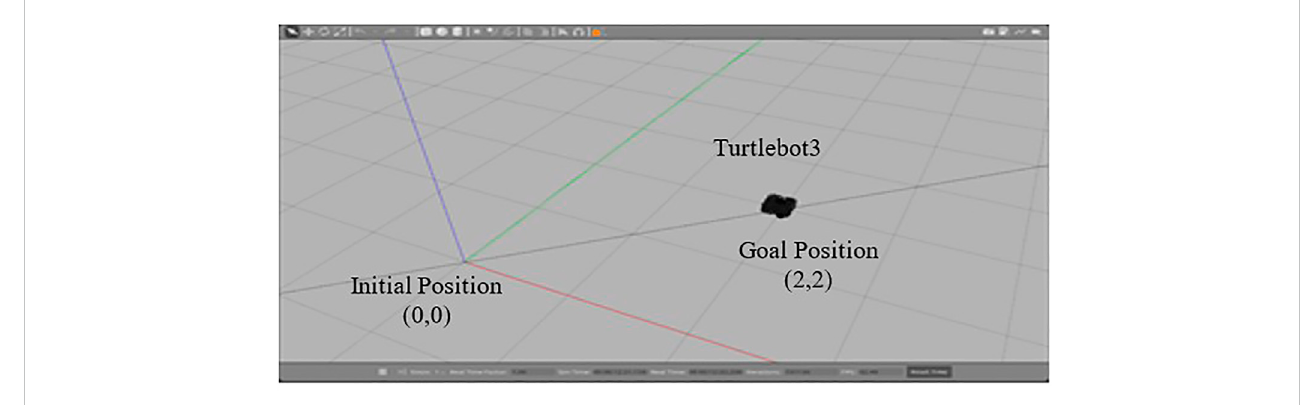
FIGURE 8 Gazebo Simulator with Turtlebot3 environment.